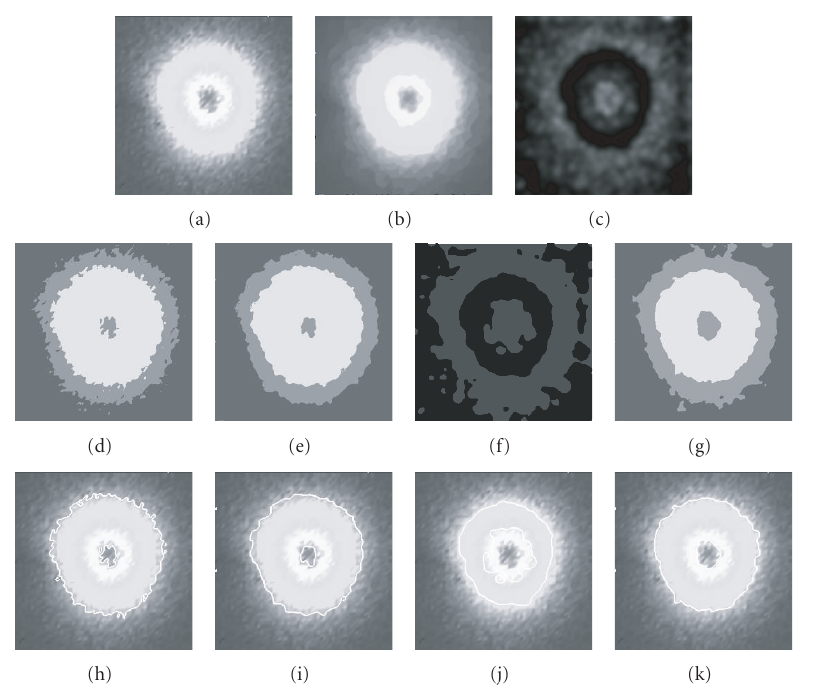
Figure 5: Segmentation results on a real molecular image: (a) the original image; (b) the denoising result with the GNF plus SRAD; (c) the texture feature image; (d) the FCM result on (a); (e) the FCM S result on (a); (f) the FCM result on the texture feature image; (g) the 2DFCM results; (h)–(k) the contours obtained from (d) to (g) superimposed on the original image,